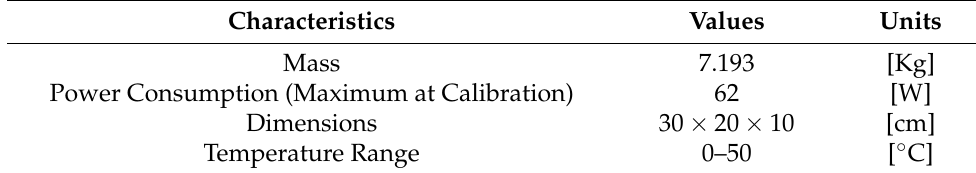
Table 4. Final L2-CalSat